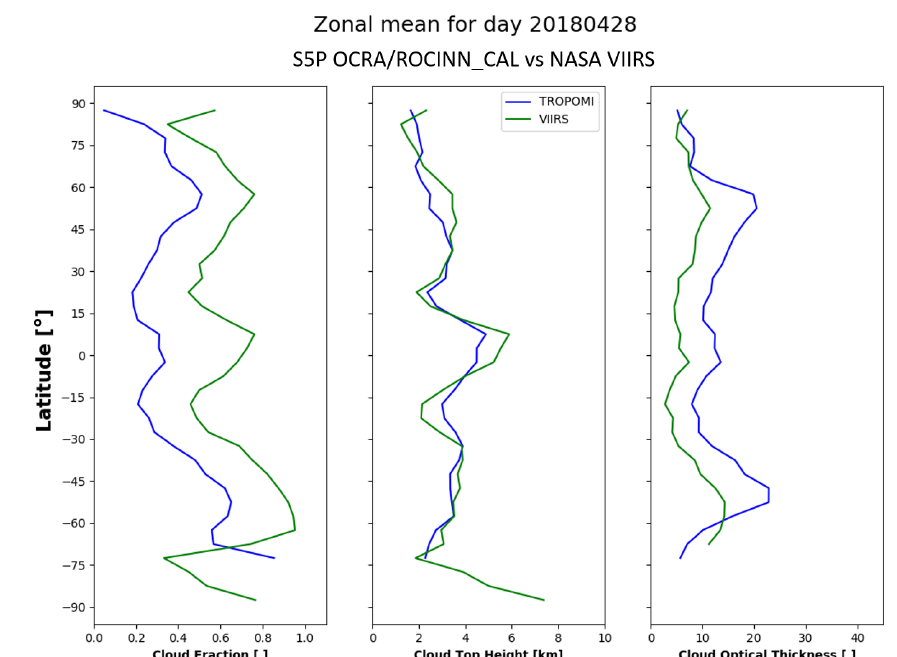
Figure 3. Zonal means for S5P OCRA/ROCINN_CAL processor version 1 (blue) and NASA VIIRS (green). The comparison refers to data from 28 April 2018 (VIIRS cloud fraction is a geometrical cloud fraction, whereas the S5P OCRA cloud fraction is a radiometric one).